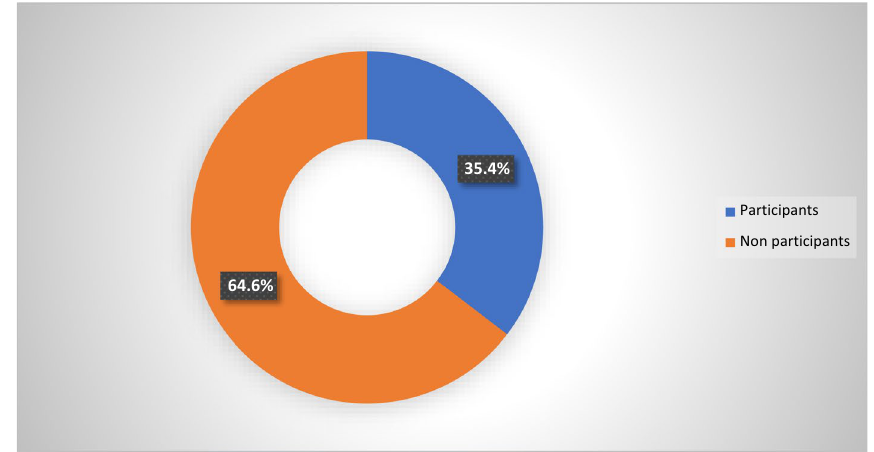
Fig. 2 Women participation status in income generating activities